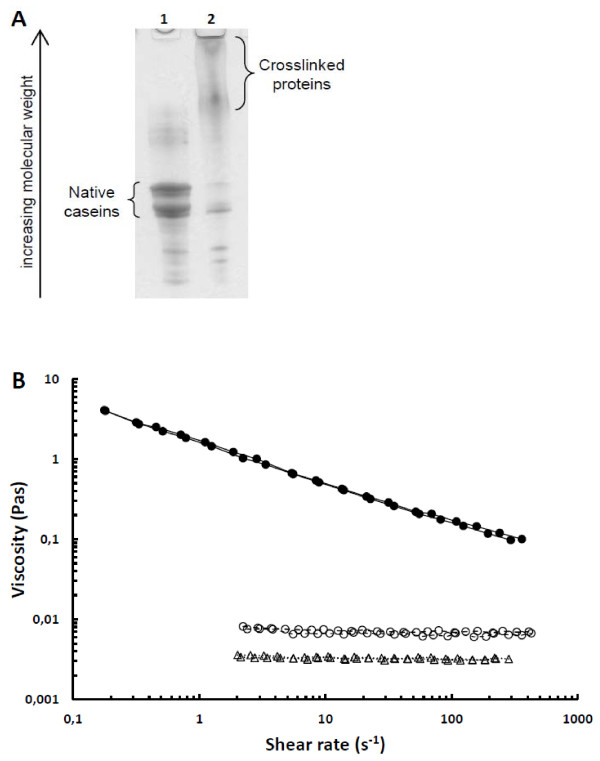
(A) SDS-PAGE-analysis of sodium caseinate powders prepared for the study. Lane 1) non-enzyme-treated sodium caseinate, lane 2) sodium caseinate crosslinked with transglutaminase. (B) Viscosity of test products as function of shear rate. For each sample, the results of two replicate measurements are shown, caseinate (−−○−−), transglutaminase-treated caseinate (−●–) or whey protein (··▽··).